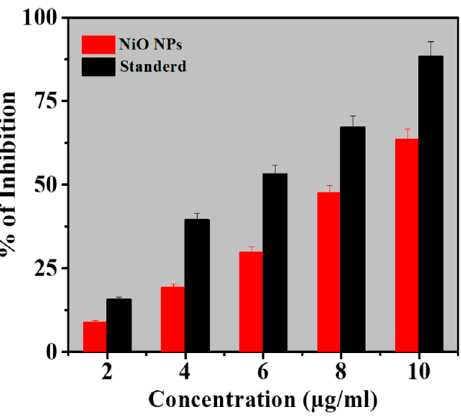
Figure 5. Antioxidant activity of NiO NPs compared to L-ascorbic acid as standard (Mean ± SD; n = 3).